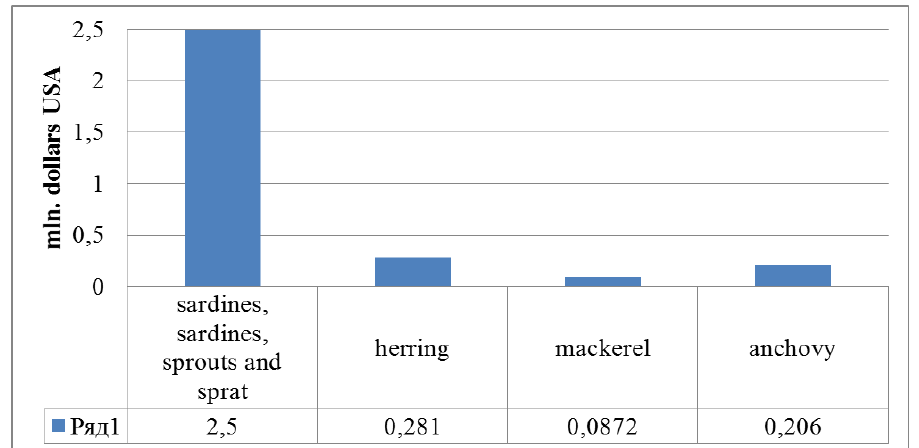
Fig. 7. The export of processed or canned fish products of Ukraine in 2019, millions of